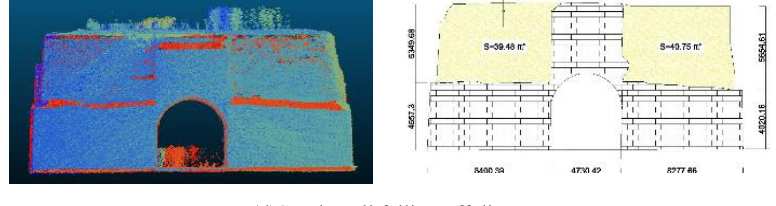
Figure 7. Measurement of falling off area of drum tower